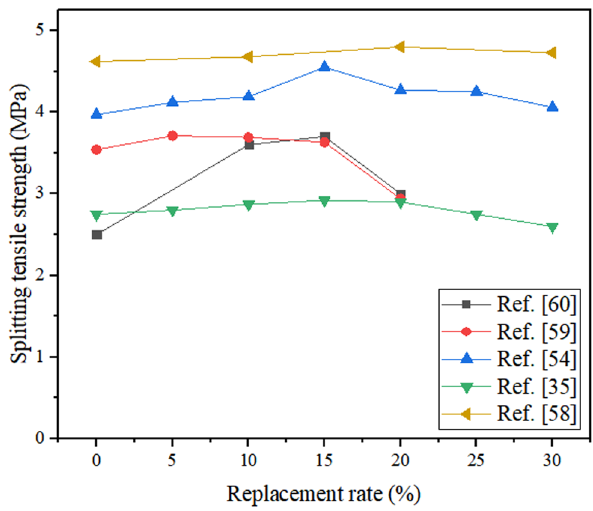
Figure 9: Splitting tensile strength of RHA – SCC [ 35,54,58 – 60 ]